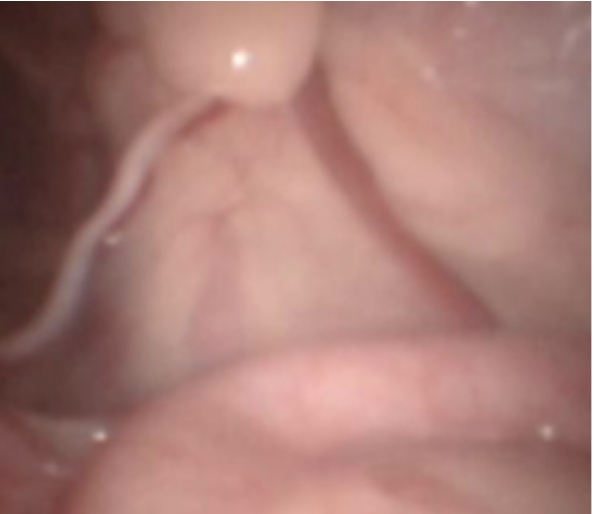
Figure 1. Laparoscopic anatomy of the vas deferens (black arrow), and the artery and vein plexus (white arrow) at the entrance of inguinal canal.